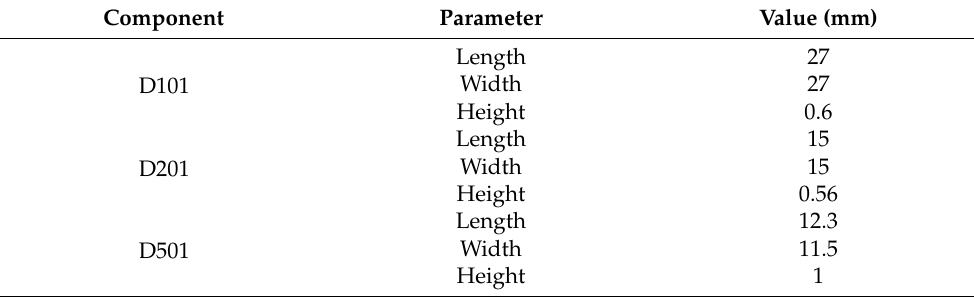
Table 2. Packaging structure parameters in FEA.